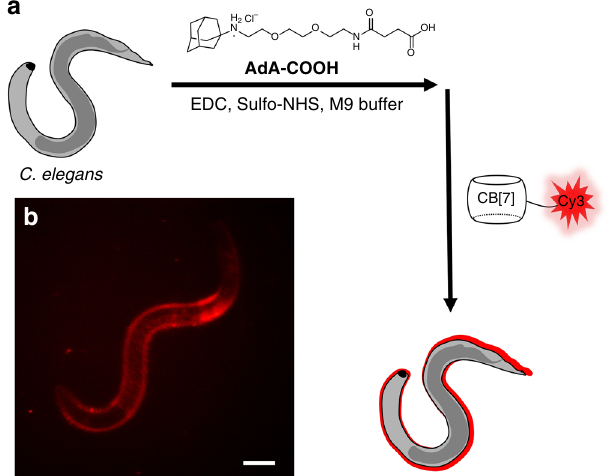
Fig. 8 Visualization of a simple animal model ( C. elegans ). a Schematic illustration of adamantylation on C. elegans and b fl uorescence microscopy images of C. elegans after treating with Cy3-CB[7]. Scale bar = 50 μ